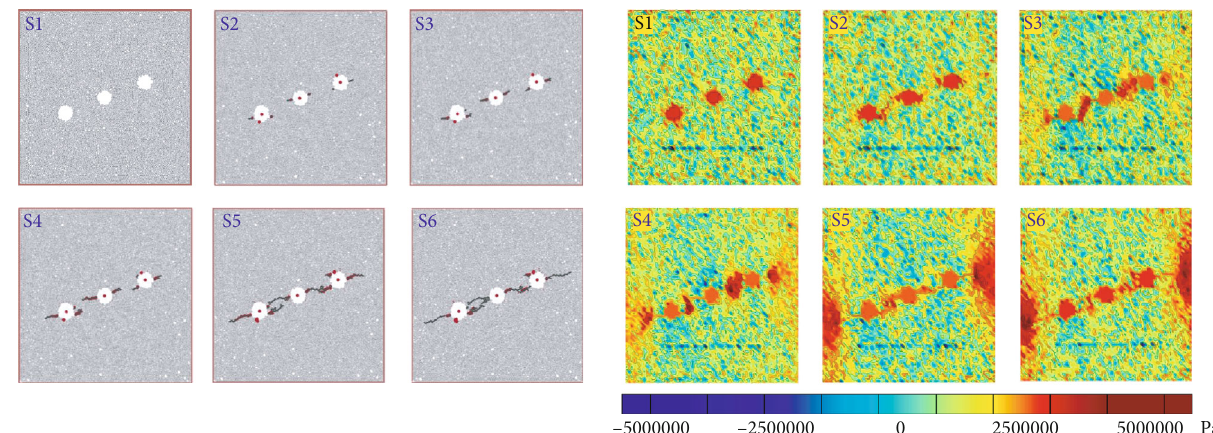
Figure 11: Hydraulic fracture propagation stage.